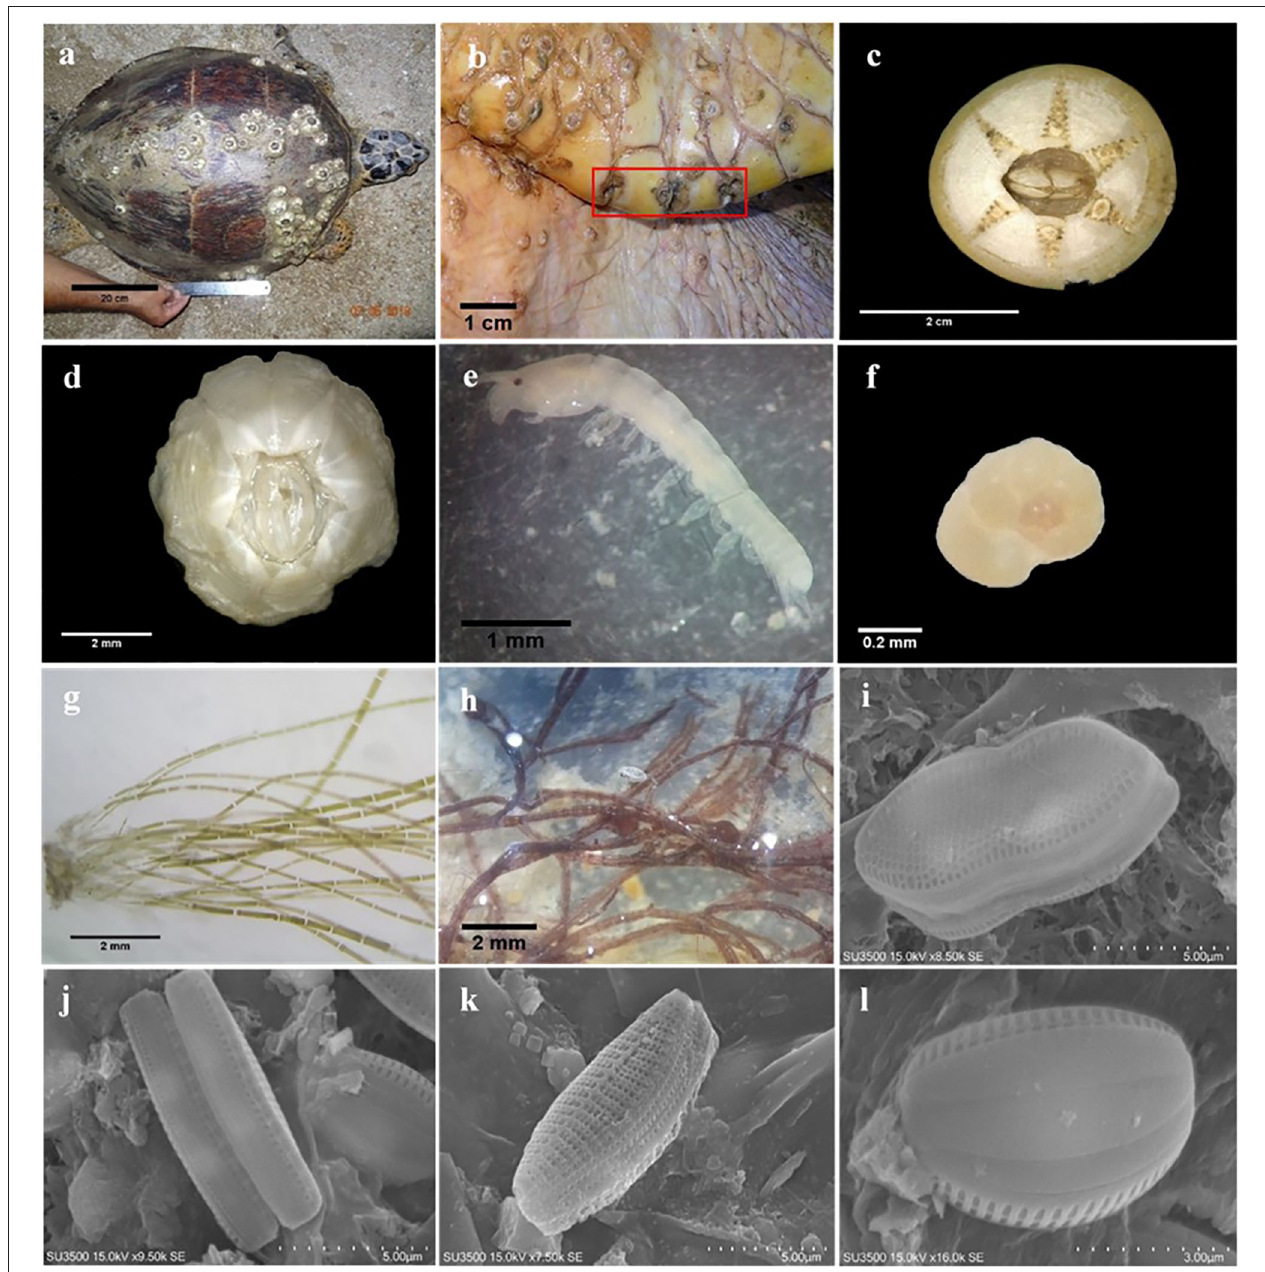
FIGURE 2 | Examples of epibiont taxa recorded on the body surface of hawksbill sea turtles in the Iranian coasts of the Persian Gulf: (a) C. testudinaria on the carapace of hawksbill sea turtle; (b) specimens of Stephanolepas muricata ; (c) Chelonibia testudinaria ; (d) Platylepas hexastylos ; (e) Tanaid; (f) Rotaliid foraminifer; (g) Chaetomorpha sp.; (h) Polysiphonia sp.; (i) Psammodictyon sp.; (j) Nitzschia sp.; (k) Tabularia sp.1; (l) Amphora sp.1.